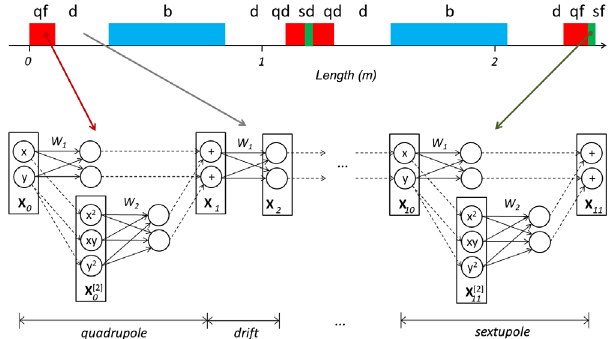
FIG. 2. Schematic representation of a FODO structure with eight magnets and a corresponding TM-PNN. The lattice consists of drifts (d), bending magnets (b), shown in blue, focusing (qf) and defocusing (qd) quadrupoles, shown in red, and focusing (sf) and defocusing (sd) sextupoles, shown in green.